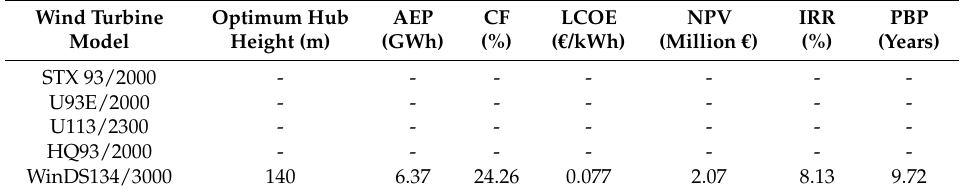
Table 10. Techno-Economic parameters at Optimum hub height in case of